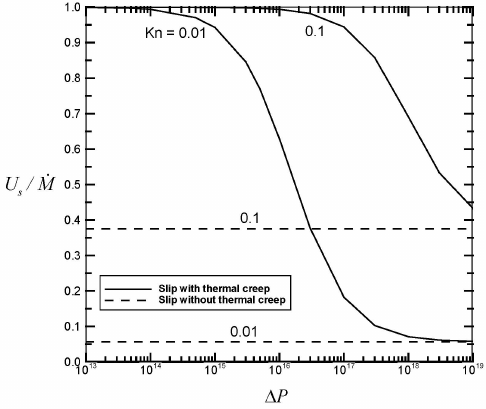
. M versus the dimensionless pressure drop ∆ P for different values of Kn with Figure 2. Velocity slip U s { GrL = 10 2 and Ec = 10 ´ 20 .